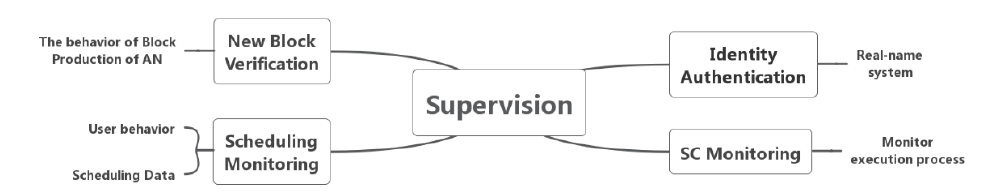
Figure 11. Supervision in system.